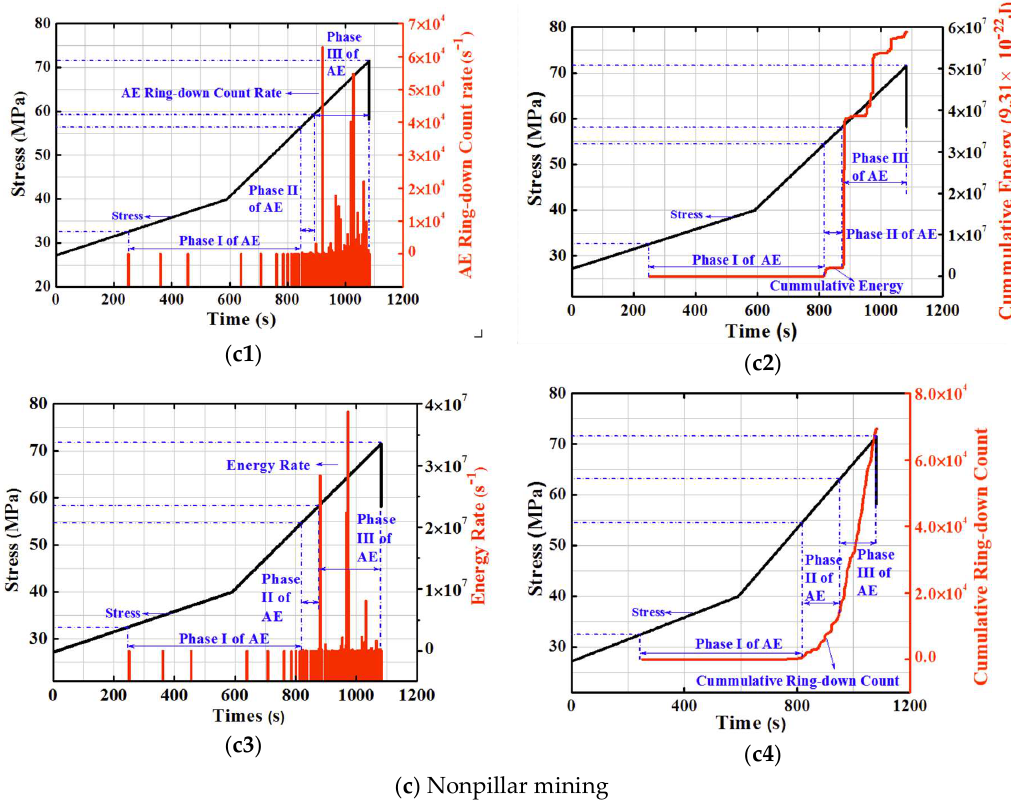
Figure 6. Evolution of the AE ring-down count rate, cumulative energy, energy rate and cumulative ring-down count over time.